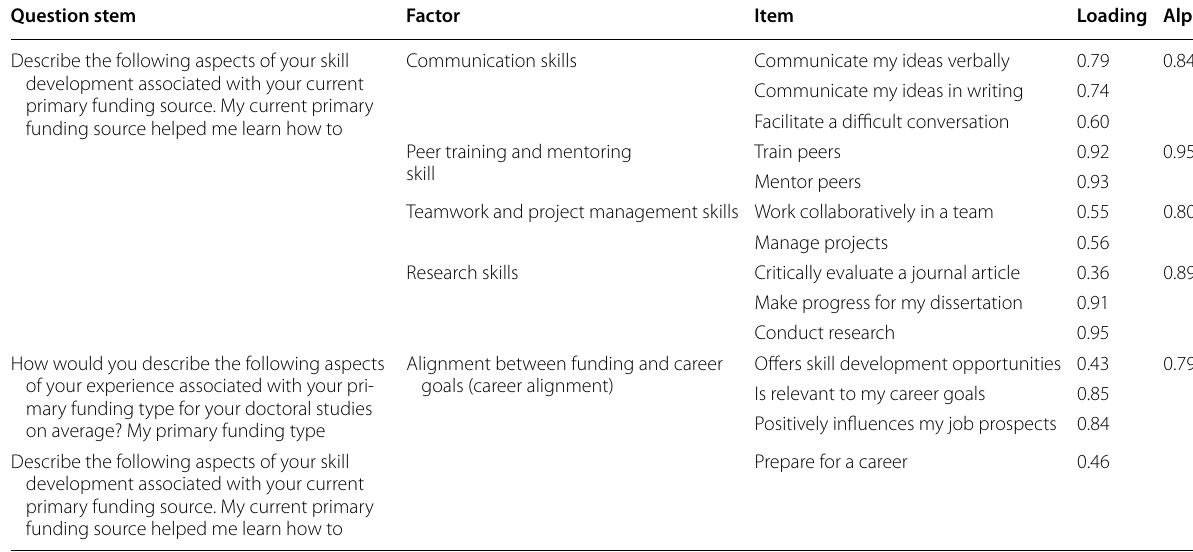
Table 2 Exploratory factor analysis results of dependent and focal independent variables Question stem Factor